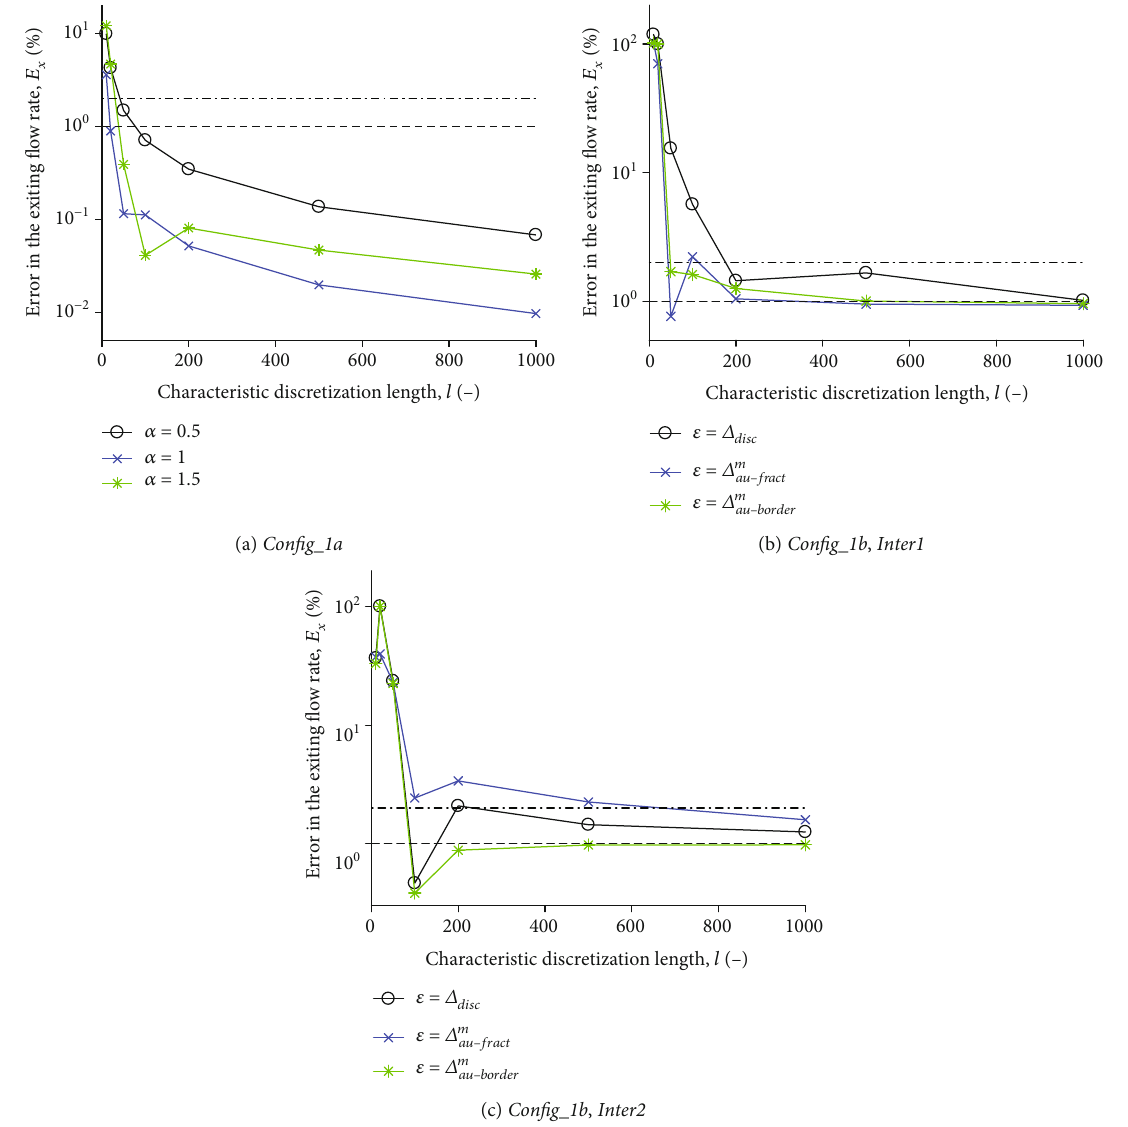
Figure 5: Error in the exiting fl ow rate E (%) along the characteristic discretization length l = L / Δ x for various values of the coe ffi cient α with the fracture con fi guration Con fi g_1a (Figure 3(a)). (b, c) Various de fi nitions of ε are tested for the fracture con fi guration Con fi g_1b (Figure 3(b)) using the methods (b) Inter1 and (c) Inter2 to de fi ne the subfractures of the system. The dashed and dotted horizontal black lines represent errors of 1 and 2 % ,